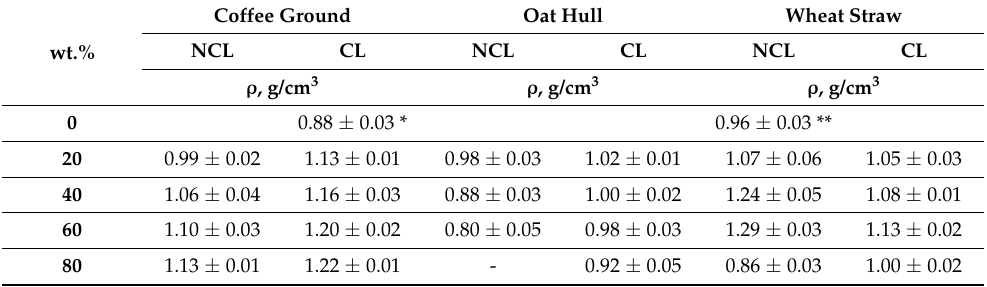
Table 5. Densities ( ρ ) of dry agro-waste pellets with crosslinking (CL) and without crosslinking (NCL).